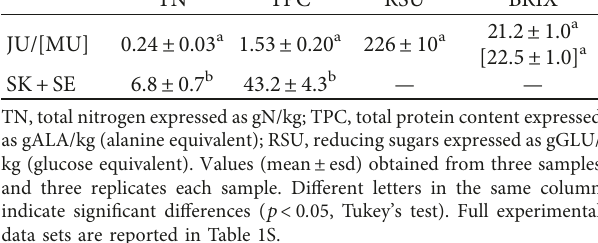
Table 1: Selected parameters for STY13 in grape juice (JU), skin (SK), seeds (SE), and must (MU).